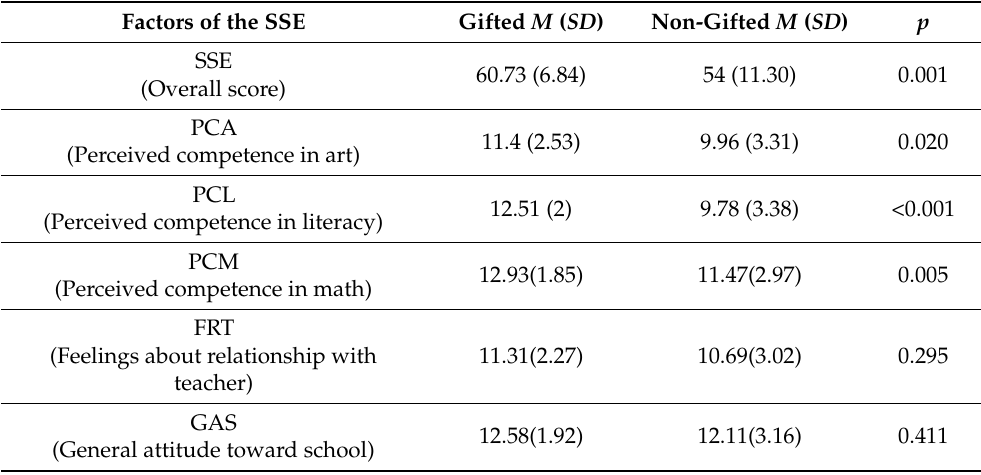
Table 5. ANOVAs: Comparison of the scores of gifted and non-gifted children on the French FAS (i.e., SSE), with means (M), standard deviations (SD), and p -value. Factors of the SSE Gifted M ( SD ) SSE (Overall score) PCA (Perceived competence in art) PCL (Perceived competence in literacy)